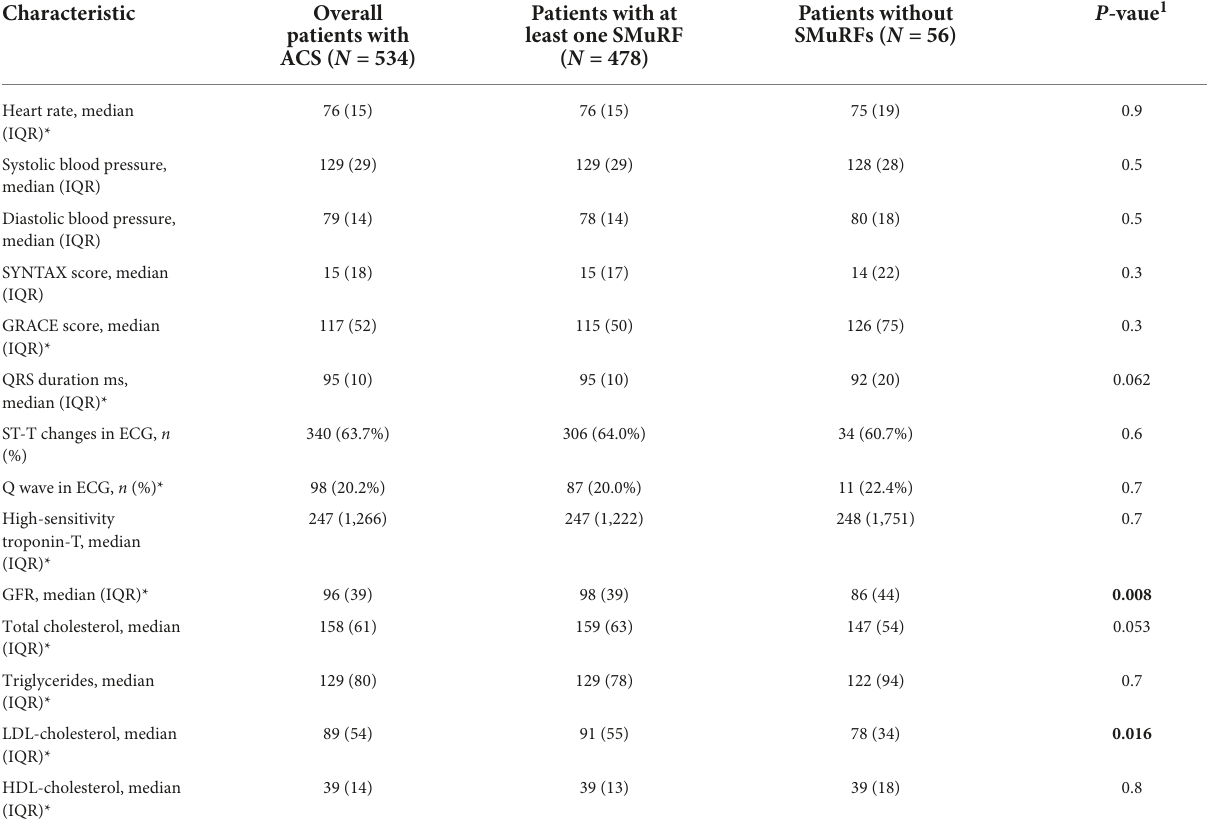
TABLE 2 Baseline clinical, laboratory, electrocardiographic, and angiographic characteristics of the included population. Characteristic